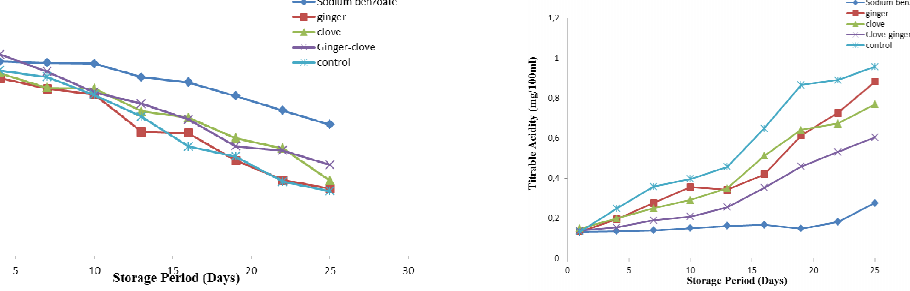
Fig. 15. Effects of various treatments on the fat content of soymilk samples at 5% concentration stored at refrigerated temperature for 25 days